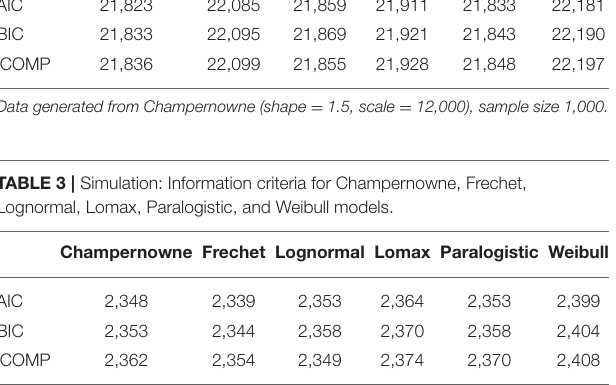
1, scale 20,000), sample size 100. = =